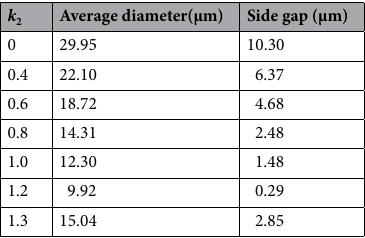
Table 2. Micro holes produced for various k 2 .